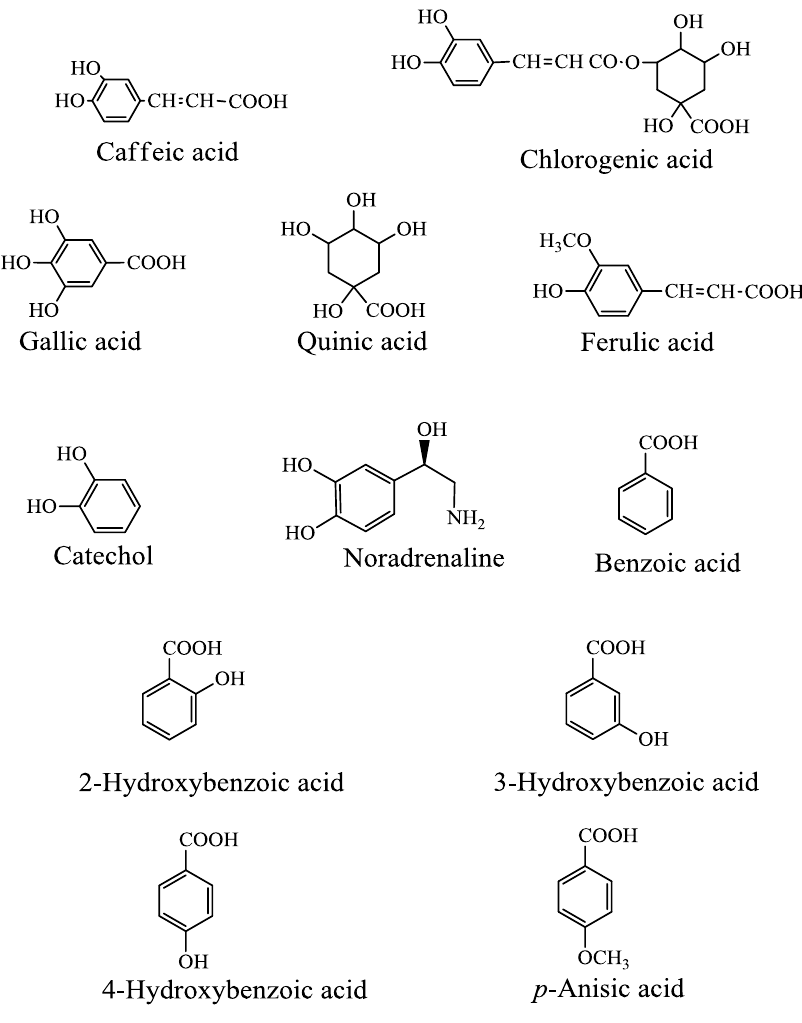
Figure 3. Chemical structures of caffeic acid and related